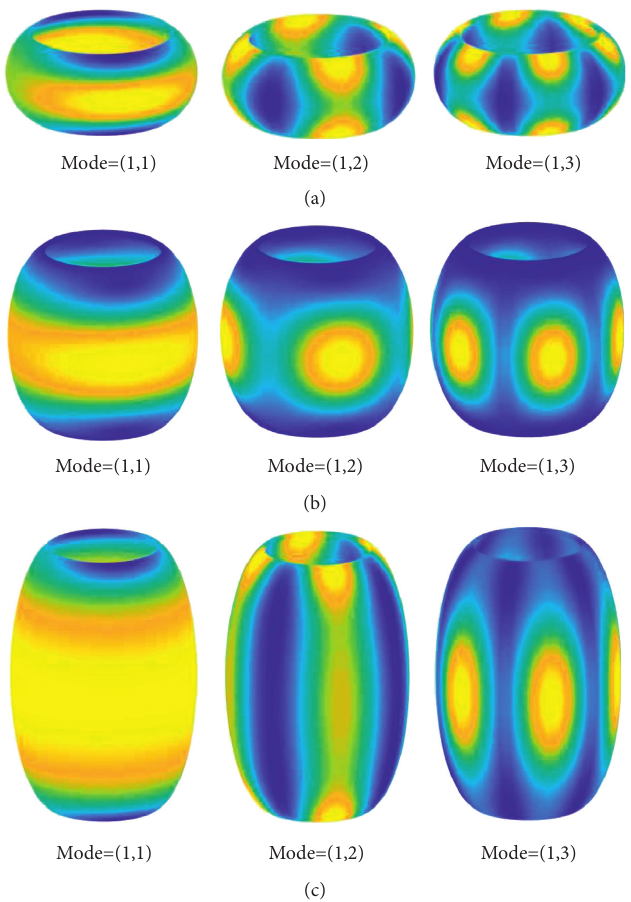
Figure 9: Several typical mode shapes for Sandwich FGP elliptical shell. (a) Elliptical shell ( b � 1) with E1-E1 boundary conditions. (b) Elliptical shell ( b � 2) with E1-E1 boundary conditions. (c) Elliptical shell ( b � 3) with E1-E1 boundary conditions. Table 8: First four frequencies for Type 2-1 Sandwich FGP doubly curved structure with diverse boundary conditions. Parabolic shell Type Mode Case